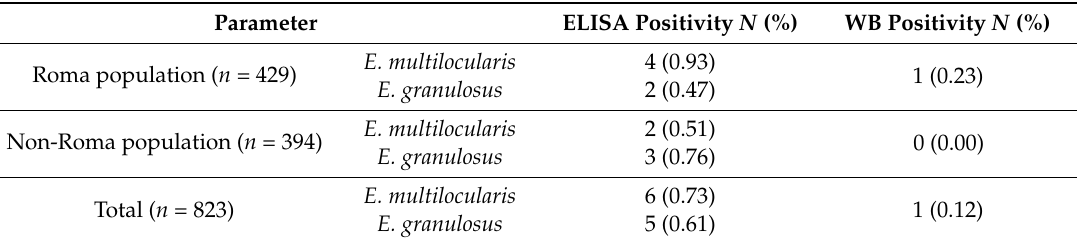
Table 4. ELISA and WB seropositivity to Echinococcus spp. in Roma and non-Roma population of Eastern